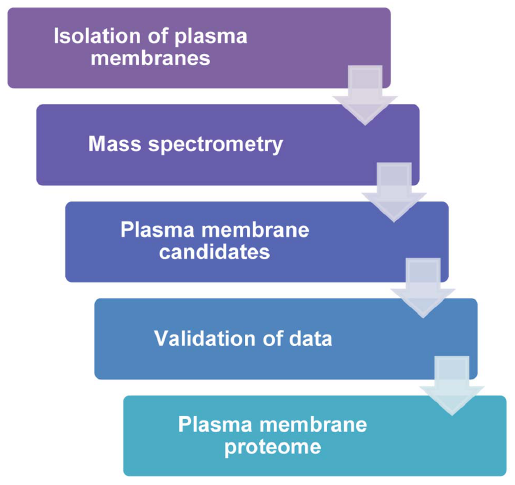
Figure 1. Workflow outlines process of obtaining plasma membrane proteome of multiple BC cell lines. After establishing an effective method for isolating plasma membrane proteins, representatives from each of the currently defined classes of BC were cultured and plasma membranes were isolated and subjected to MS, yielding a comprehensive list of protein identifications having an FDR # 1%. These data were biologically validated and the data were mined for relevant protein candidates.